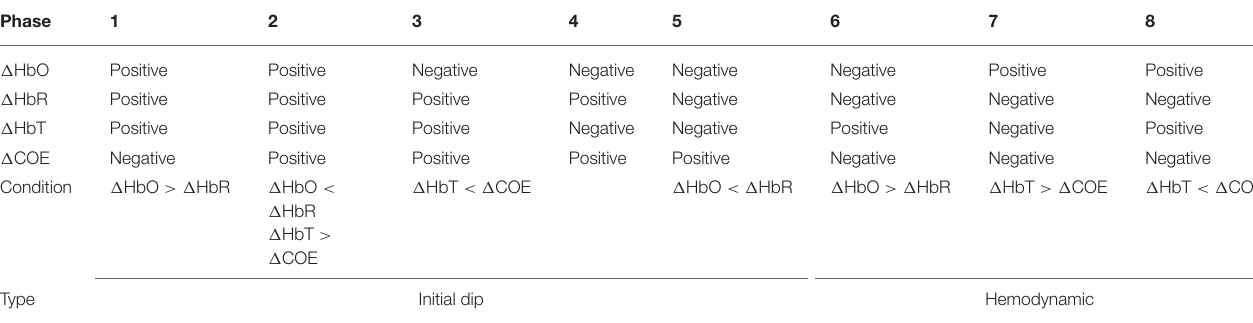
TABLE 2 | Different phases in the vector diagram related to initial dip and hemodynamics.